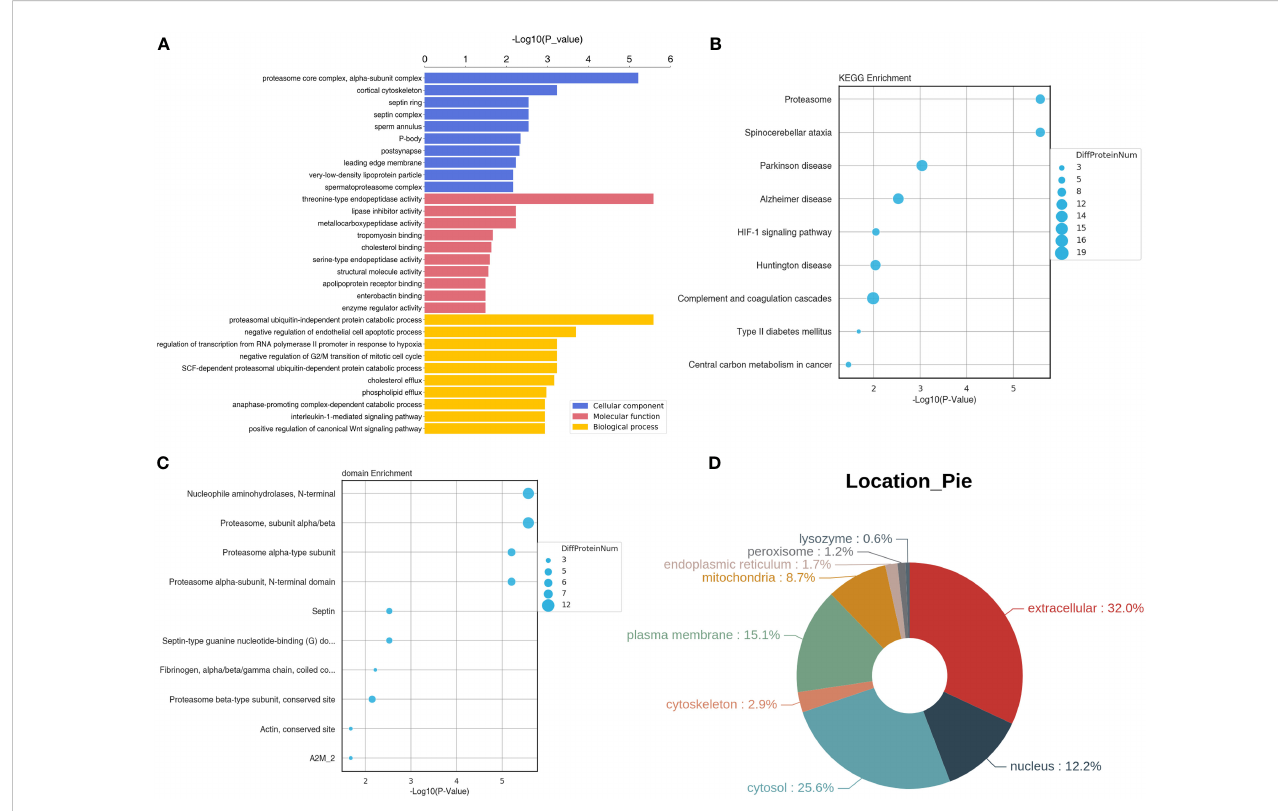
FIGURE 6 Functional and subcellular localization analyses of the identi fi ed DEPs. (A) GO terms of the identi fi ed DEPs. (B) Top 10 KEGG pathway enrichment of these DEPs. (C) Top 10 signi fi cant enriched protein domains of these DEPs. (D) The Pie of subcellular localization of the screened